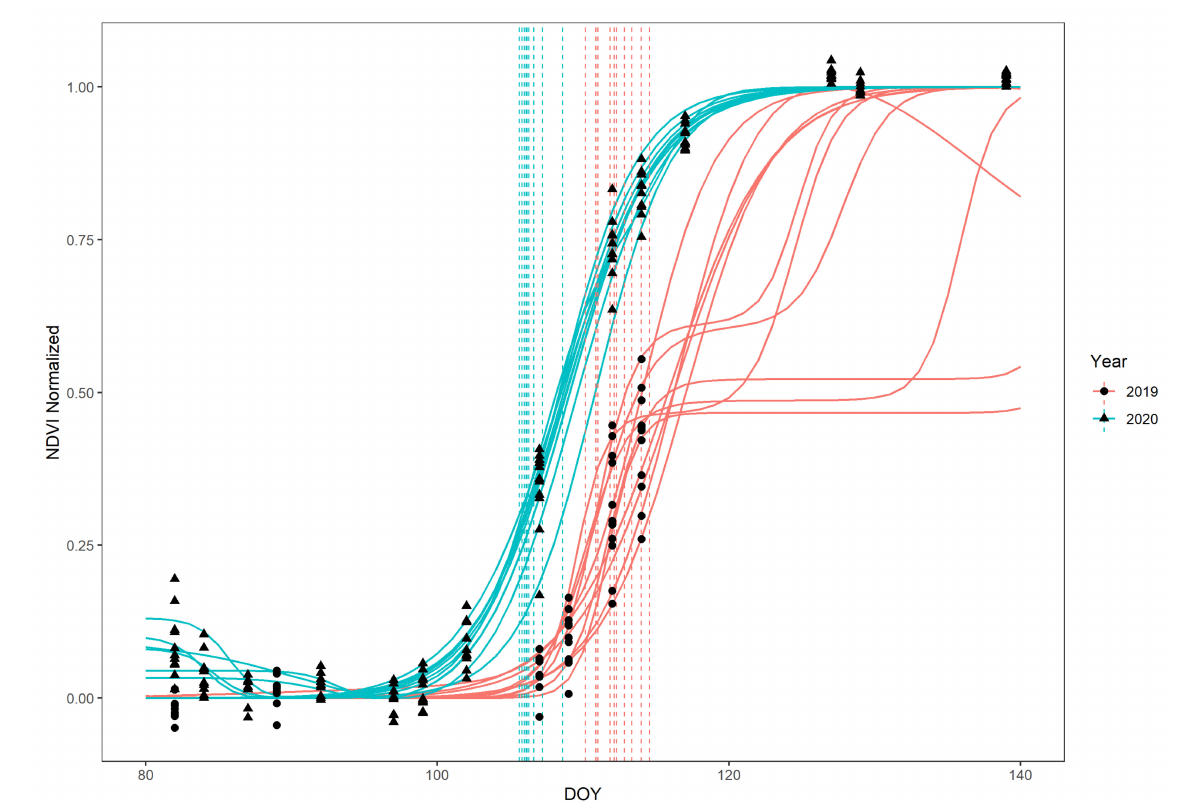
Figure A3. All normalized NDVI time series from Sentinel-2 data set 1 for one quadrant (Q4). Each curve represents a double-logistic function to normalized NDVI time series (symbols for single NDVI acquisitions, circles for 2019 and triangles for 2020) of a single tree crown. Red for 2019 and blue for 2020. Vertical dashed lines represent start of season (SOS) as the moment at which the curves reached a threshold of